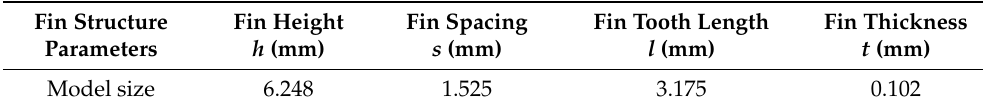
Table 1. The original data of the structure size of serrated-fin by simulation.